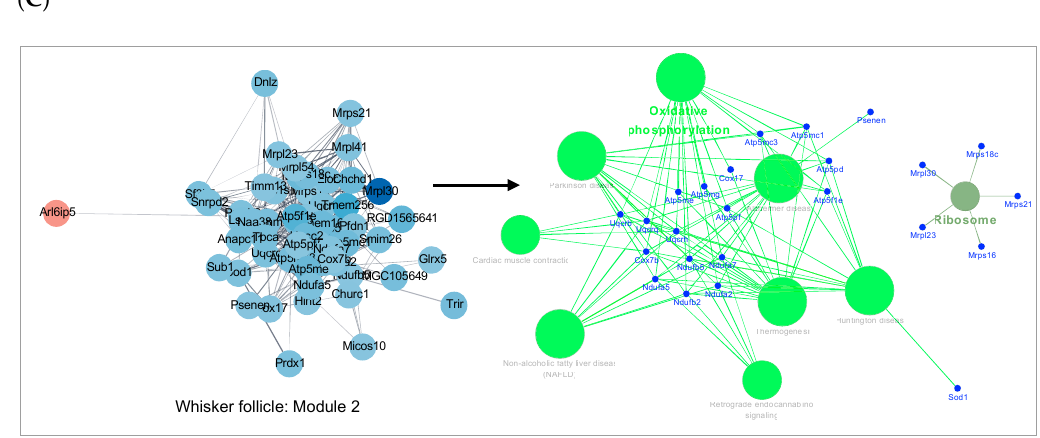
Figure 5. Cluster analysis of DEGs in whisker follicles or in the striatum. ( A – C ) Gene pathway networks that represent significantly enriched KEGG terms and related genes in designated modules.